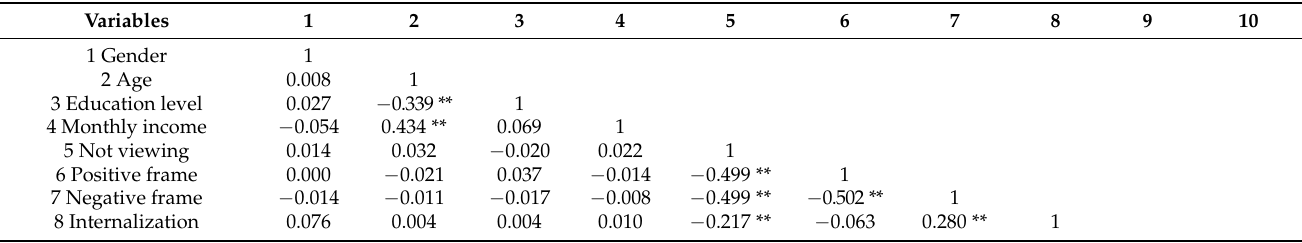
Table 2. Mean, standard deviation, and